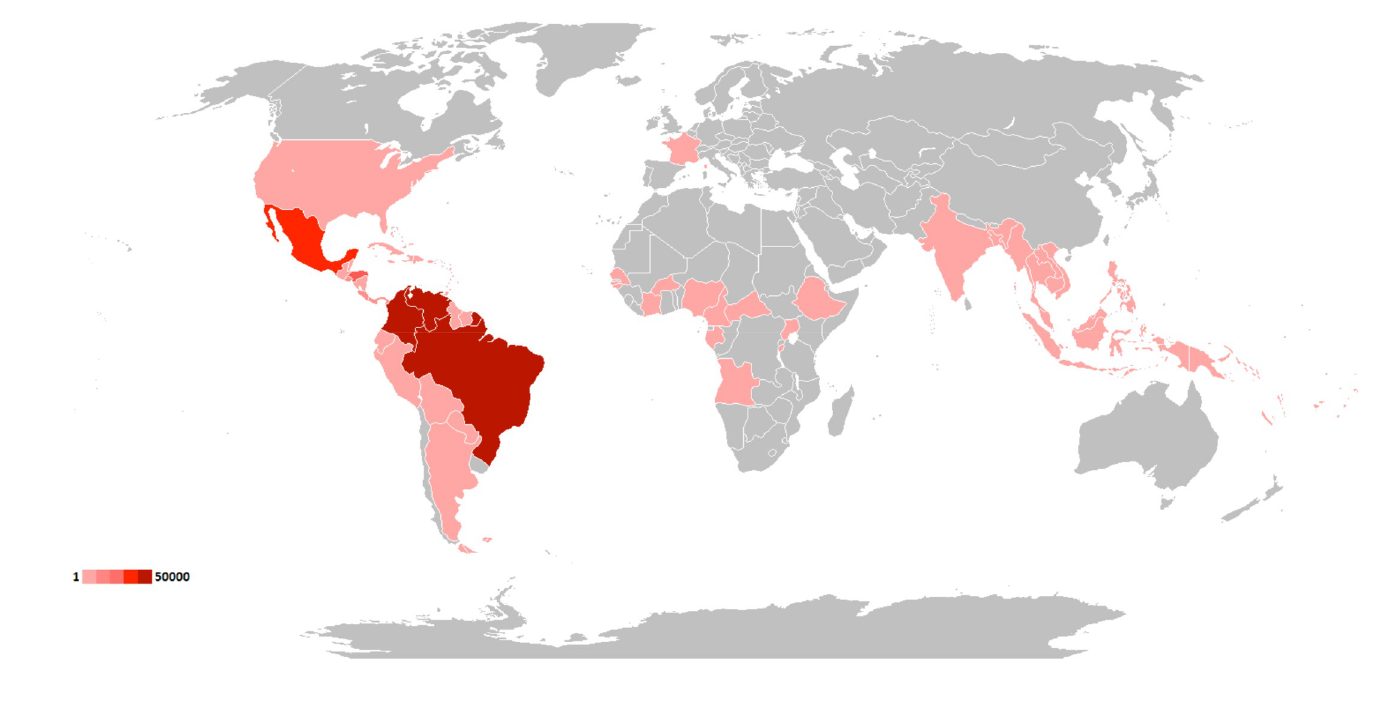
Fig 3. Global distribution of ZIKV. Countries having transmission of Zika, with gradient indicating average number of reported cases per year from 2010 to 2019. Map created using an open-access world map from Wikimedia Commons (https://commons.wikimedia.org/wiki/File:BlankMap-World.svg). ZIKV, Zika virus.